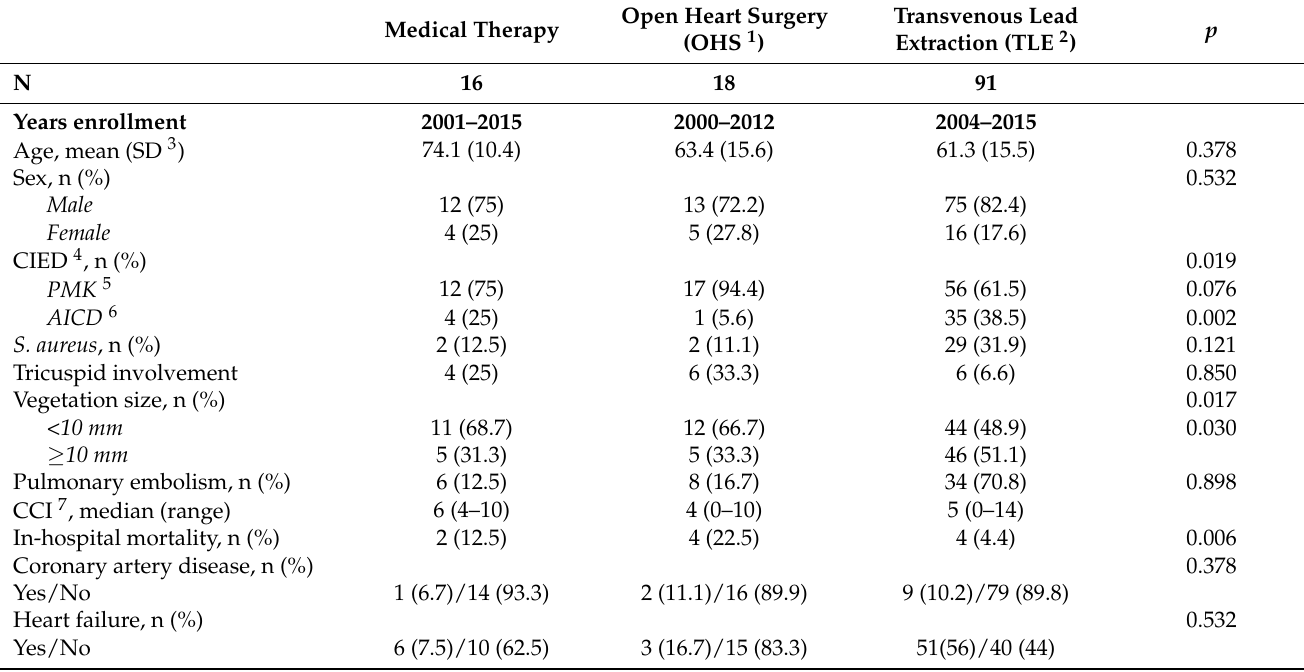
Table 4. Clinical features of patients grouped according to the actual therapeutic